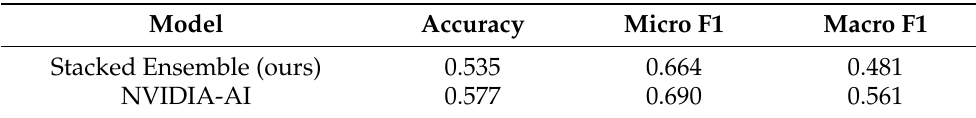
Table 5. Comparison of our model with